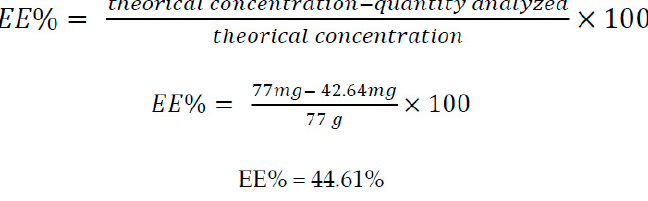
Figure 10. Equation substituted with units to obtain the encapsulation efficiency. Table 9. Load capacity and encapsulation efficiency of methacrylic acid–ethyl acrylate copolymer